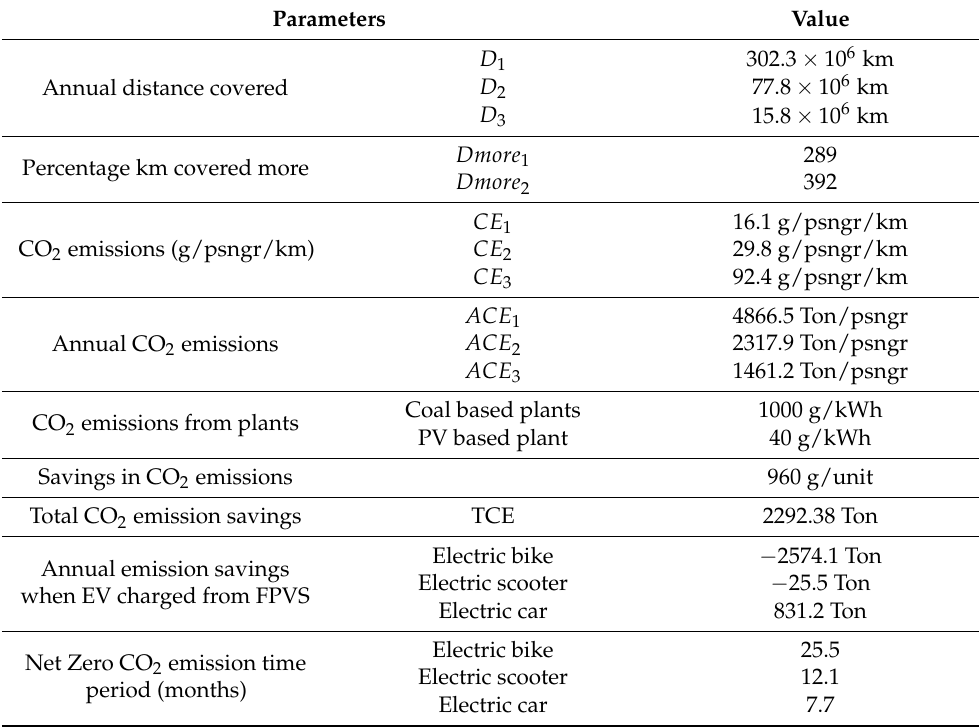
Table 3. Annual CO 2 emission savings for different types of EVs when charged from FSPVS.